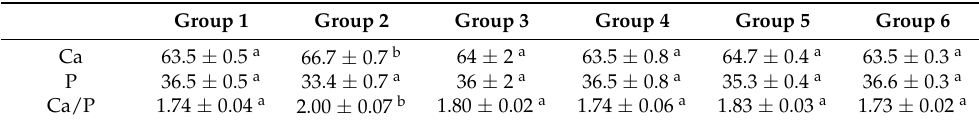
a,b Different superscript letters indicate statistically significant